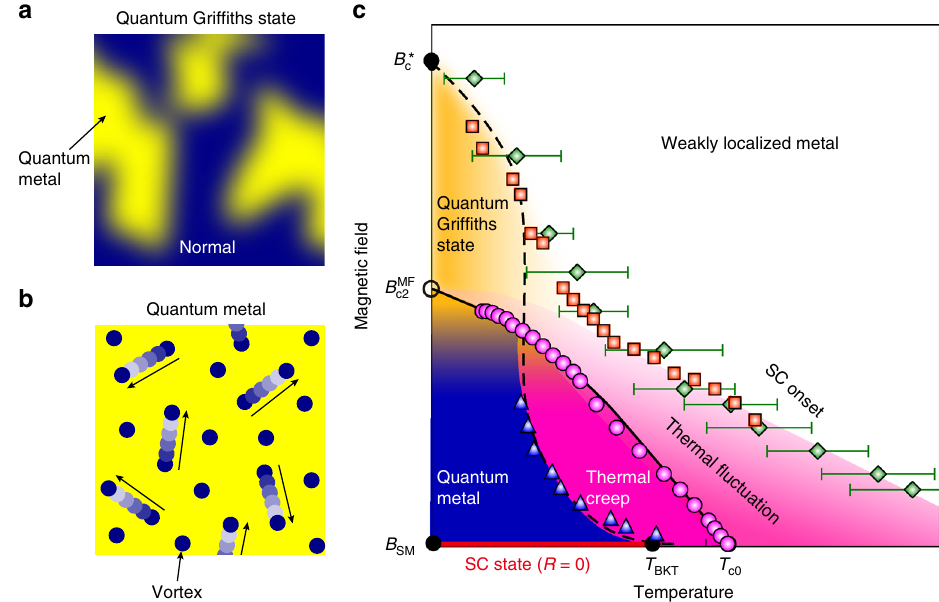
Fig. 4 B – T phase diagram of highly crystalline 2D superconductors. a Schematic image of quantum Grif fi ths state. Blue and yellow regions represent normal and quantum metallic state (rare regions), respectively. b Schematic image of quantum metallic state. In this state, vortices (blue circles) show creep motion in the superconducting region (yellow region). The quantum metallic phase in Fig. 4a is the same as that in Fig. 4b. c The plotted data based on Supplementary Figure 5a. T c0 is the transition temperature determined by the thermal fl uctuation theories (Aslamazov – Larkin and Maki – Thompson model), and true superconducting state (zero-resistance state) is realized below the Berezinskii – Kosterlitz – Thouless (BKT) transition temperature ( T BKT ) 4 . Blue triangles show the crossover temperature T cross between the thermal creep regime and the quantum creep regime (see Supplementary Figure 4). Orange squares, green diamonds, and pink circles show the crossing points B c of R – B curves in Fig. 2b, d at neighboring temperatures, the superconducting onset T onset (see Supplementary Figure 1), and the mean fi eld upper critical fi eld B c2 MF derived from the Ullah – Dorsey (UD) scaling 19 , respectively. Error bars of green diamonds represent the ambiguity of T onset de fi ned by d R sheet /d T = 0 due to the experimental resolution (see Supplementary Figure 1). Under a relatively low magnetic fi eld, the fi nite resistance state occurs due to the thermal creep (pink region) and quantum creep (blue region) in the relatively high and low temperature region, respectively. B SM is the hypothetical transition magnetic fi eld from the zero-resistance state to the quantum metal 32 (vortex liquid). The system eventually exhibits the quantum Grif fi ths state (orange region) up to the characteristic critical magnetic fi eld B c * . The black solid and dashed curves show the B c2 MF ( T ) based on the Wertharmer – Helfand – Hohenberg (WHH) model and, crossover curve between thermal fl uctuation region and quantum fl uctuation region,